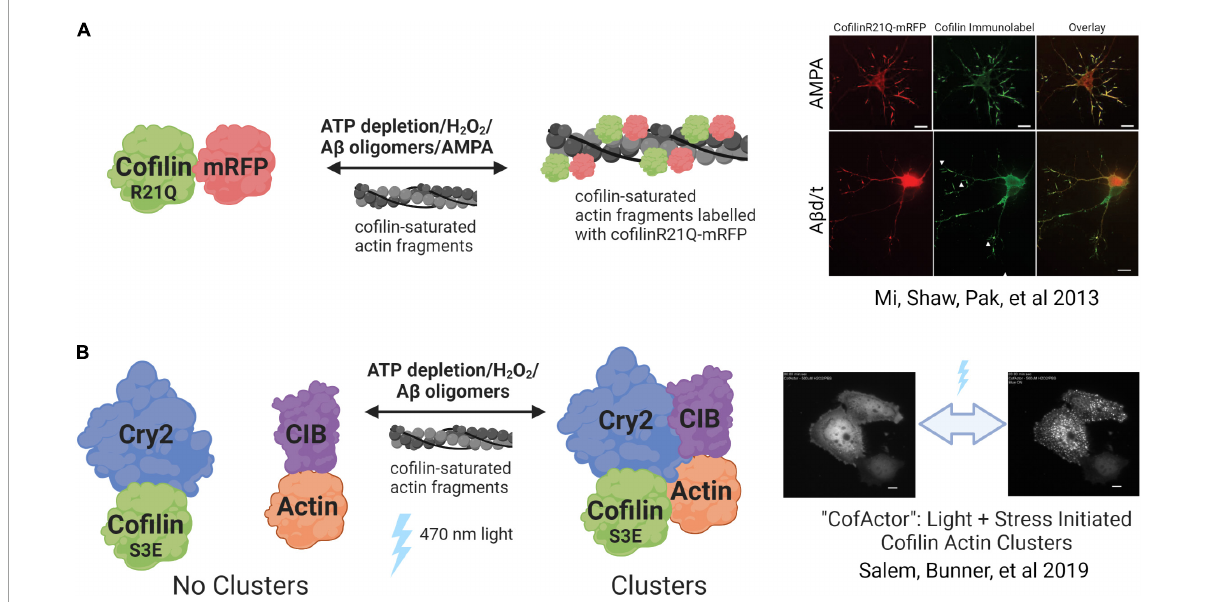
FIGURE4 Genetically encoded cofilin-actin rod reporters. (A) CofilinR21Q-mRFP incorporates into cofilin-actin rods formed under various stress-inducing stimuli. The association is reversible once the stress solution is removed from cells. (B) CofActor (Cry2-Cof.S3E and Actin-CIB) forms rod-like structures in response to a combination of stress-inducing stimulus and blue light. The clusters revert to the non-associated state once the blue light is turned off. Created with